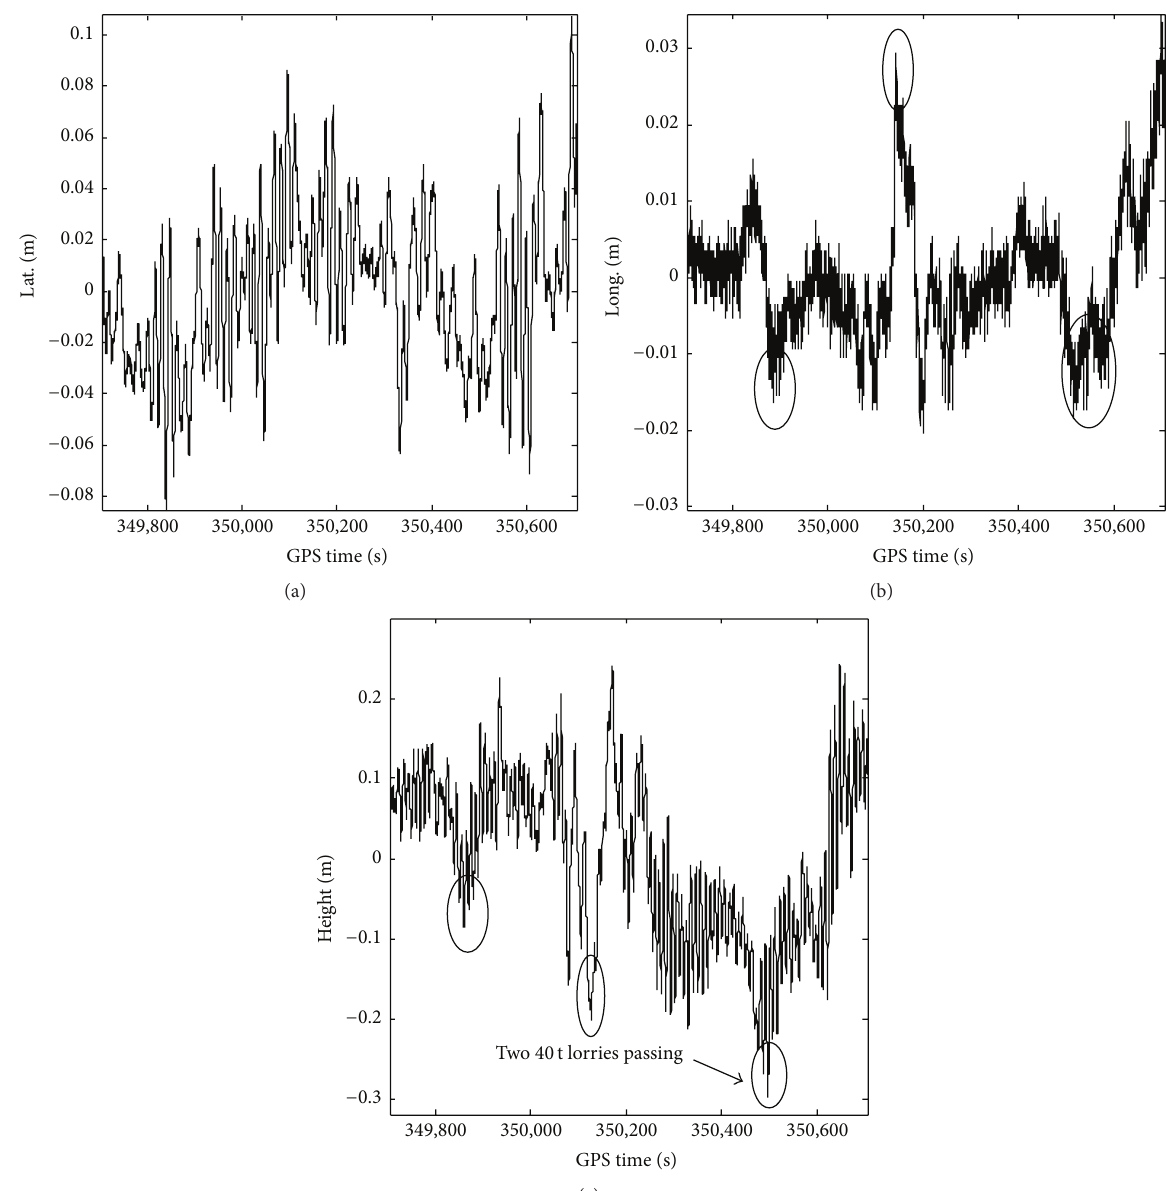
Figure 22: Absolute deflections of bridge site F during the two 40 t lorries passing.